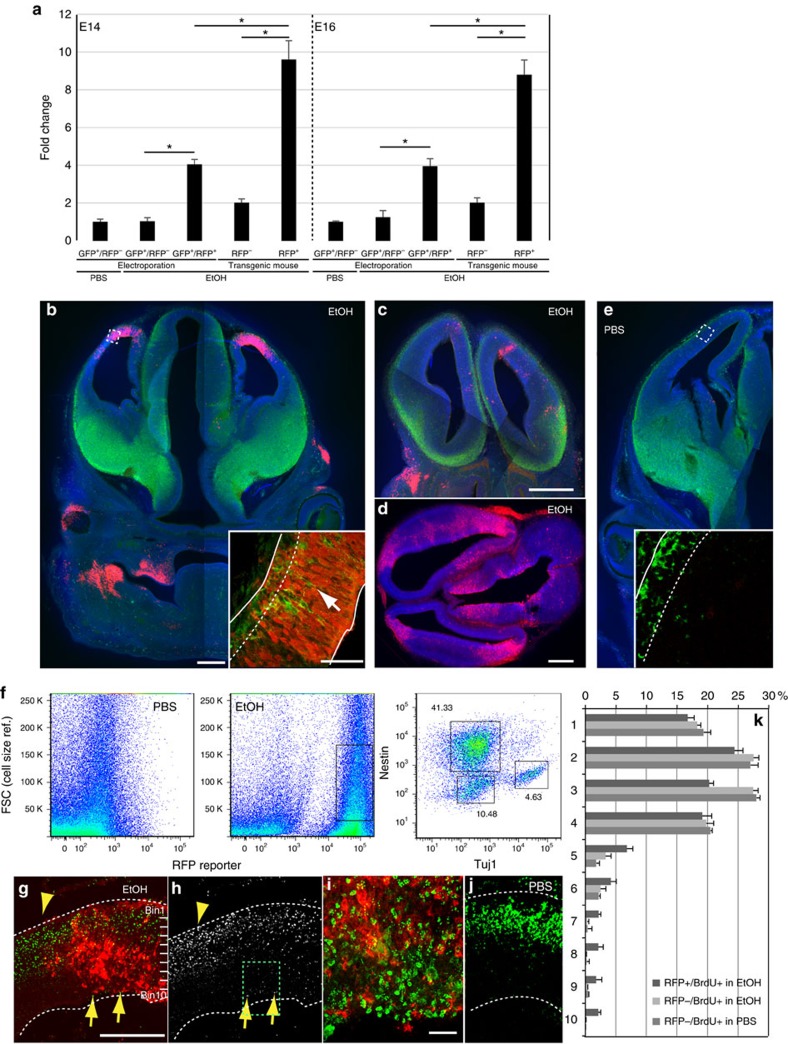
Heterogeneity in the reporter expression of Hsf1–Hsp signalling and the migration deficiency in reporter+ cells in the cortex.(a) Different sensitivity for detection of Hsf1–Hsp signalling activation between IUE- and transgenic-based reporter assays. qRT–PCR of Hsp70 was performed with the total RNA extracted from reporter-positive and -negative cells sorted by a flow cytometer 8 h after administration at E14 (left) or E16 (right). Data are represented as mean±s.e.m. *P<0.0001 by t-test from three independent experiments using multiple embryos from several dams. (b,c,d) Heterogeneous reporter expressions of Hsf1–Hsp signalling driven by EtOH exposure at E15 (b) or 16 (c,d) in three HSE–RFP reporter transgenic mice 1 day after last exposure. Each sample shows a distinct reporter expression pattern. Reporter-expressing regions contain Tuj1+ immature neurons (green) incorrectly positioned in the ventricular zone (arrows in the inset in b). The square in b indicates the region from which the inset was taken. The dotted line in the inset in b shows the boundary of the cortical plate and ventricular zone. Approximately 9% of the total analysed embryos showed robust reporter expression (n=10/115 embryos) (green: Tuj1, red: HSE–RFP, blue: DAPI). (e) No reporter expression after PBS (control) exposure. (0/137 embryos). (f) Flow cytometric analysis of reporter expressing cells dissociated from E16 cortices 1 day after the last exposure. The percentages of Nestin+/Tuj1−, Nestin−/Tuj1+ and Nestin−/Tuj1− cells were determined after gating of the RFP+ cells as indicated with a square in the EtOH-exposed sample. The objects showing larger FSC profiles are cellular debris. (g–j) Birthdate labelling with BrdU (green in (g,i,j), white in (h)) at E15 shows delayed migration of BrdU+ cells at E18 in the region containing HSE–RFP + cells (arrows) compared with the surrounding region (arrowheads), after daily administration of EtOH at E14-16. i is a higher magnification view of square in h. (k) Quantification was performed by identifying the domains that contain RFP+ cells throughout radial axis in somatosensory cortical regions. The RFP− cells were counted in the adjacent regions in EtOH exposed samples and the corresponding regions in PBS-exposed samples (RFP−/BrdU+ in PBS). *P<0.001, repeated measures ANOVA, n=3 each. Scale bars, 0.5 mm (b–h,j), and 50 μm (in the inset in b,e,i).